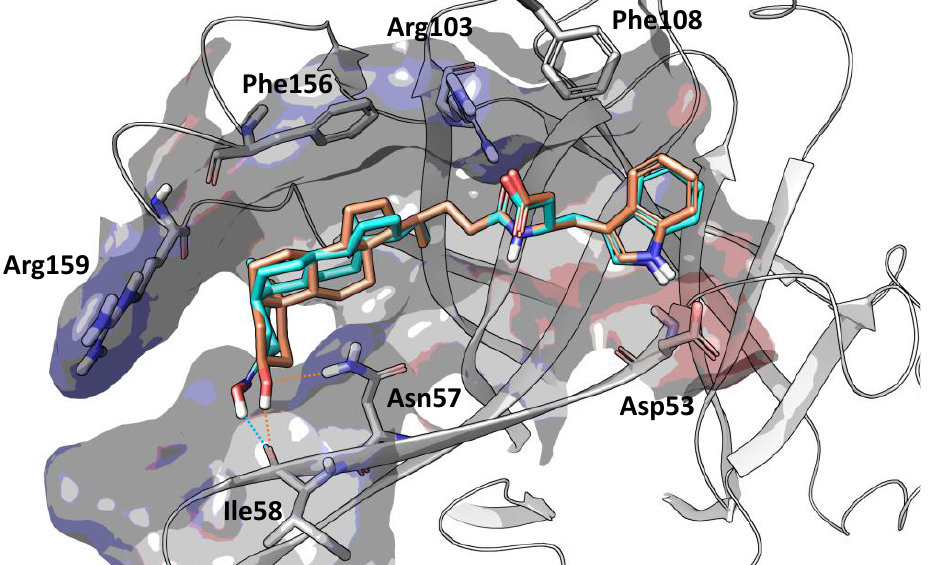
Figure 5. Binding conformation of UniPR129 (orange carbon atoms) and UniPR500 (cyan carbon atoms) within the EphA2 ligand-binding domain (white ribbons). The binding site is represented by Van der Waals surface colored according to the computed electrostatic potential. Key residues of EphA2 binding domain are labeled. Polar interactions between the substituent emerging from position 3 of the steroidal core of the studied antagonists and residues of EphA2 ligand-binding domain are highlighted with dotted orange (UniPR129) or cyan (UniPR500) lines.